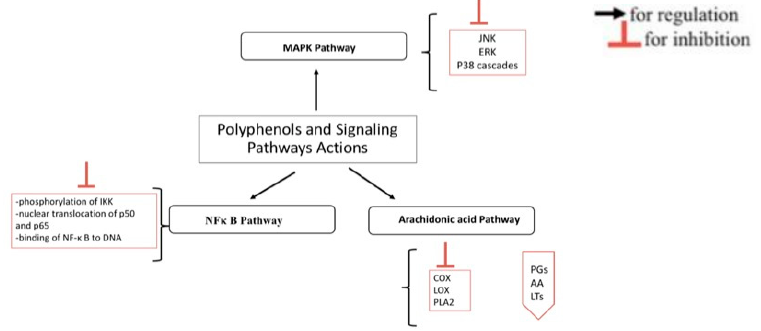
Figure 1. Potential points of action of polyphenols within inflammatory cascade. NF- κ B: